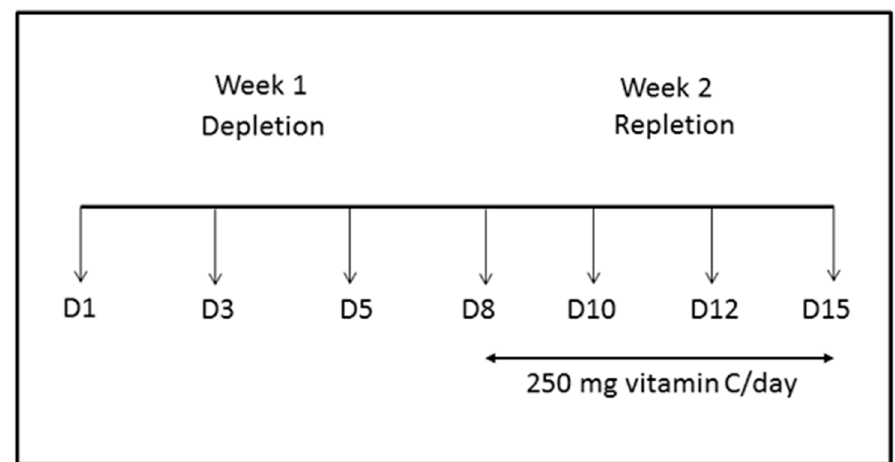
Figure 1. Steady-state study design. Participants were depleted of vitamin C-containing foods and beverages for one week and then supplemented with 250 mg of vitamin C per day for another week, in addition to returning to their normal diet. Fasting blood samples were obtained at the days indicated and analysed for plasma and erythrocyte ascorbate (D1 is day 1, etc.).